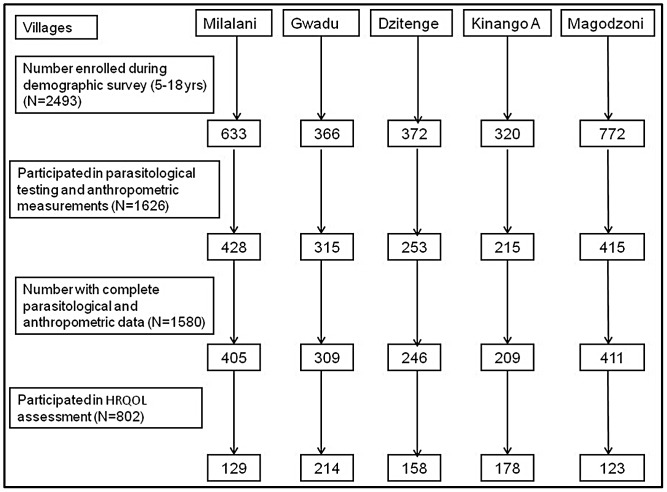
Flow chart of study participation.Numbers of children by village at enrolment, at parasitological and anthropometric testing, and at HrQoL assessment.